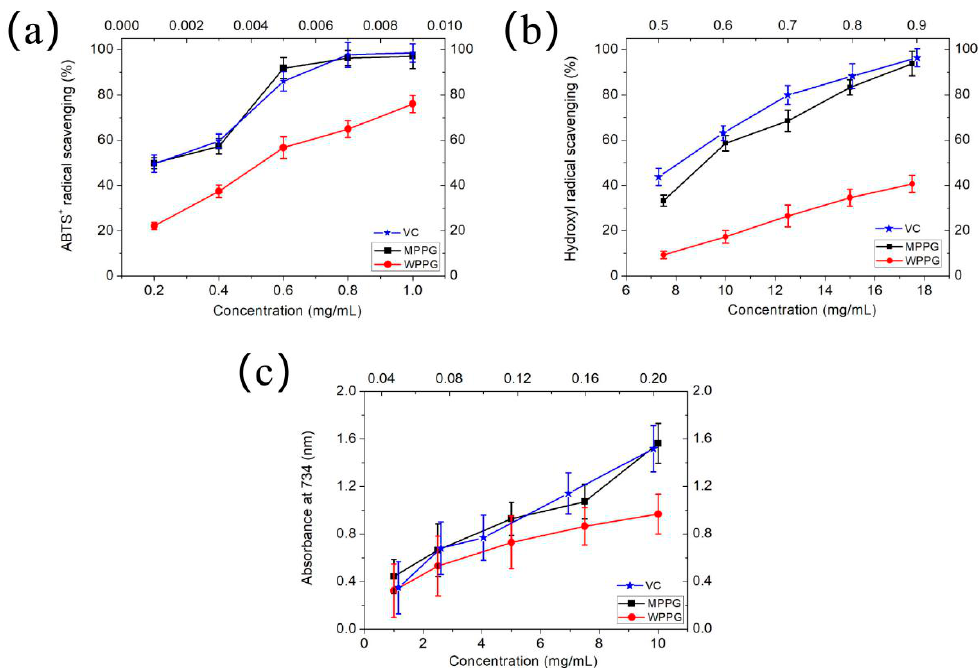
Figure 6. In vitro antioxidant activity of MPPG and WPPG by ABTS radical scavenging assay ( a ), hydroxyl radical scavenging activity ( b ), and total reducing power assay ( c ). Vitamin C (VC) was used as the positive control. Values represent mean ± SD ( n = 3).